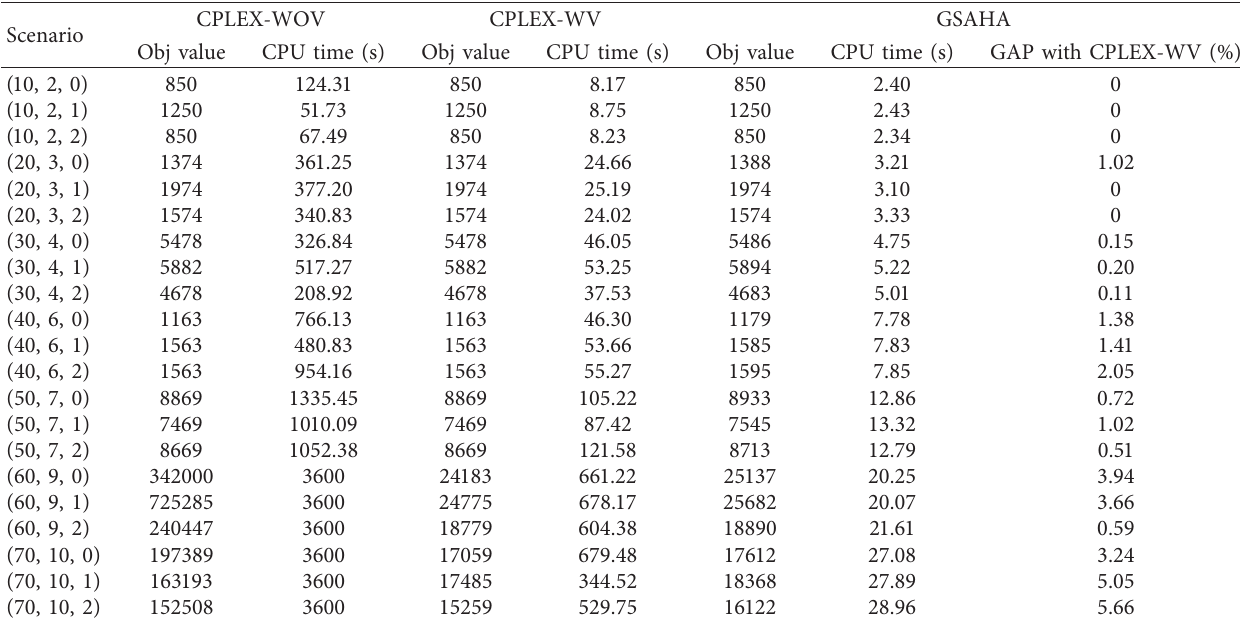
Table 9: Objective values and computation times of CPLEX-WOV, CPLEX-WV, and GSAHA under different scenarios.